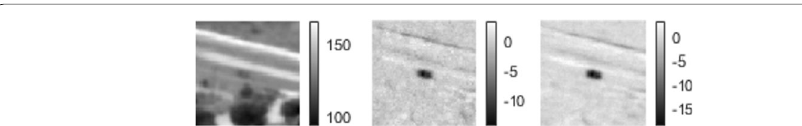
Fig. 11 Target enhancement (left—original frame, center—baseline difference, right—CVMF 5-frame difference)